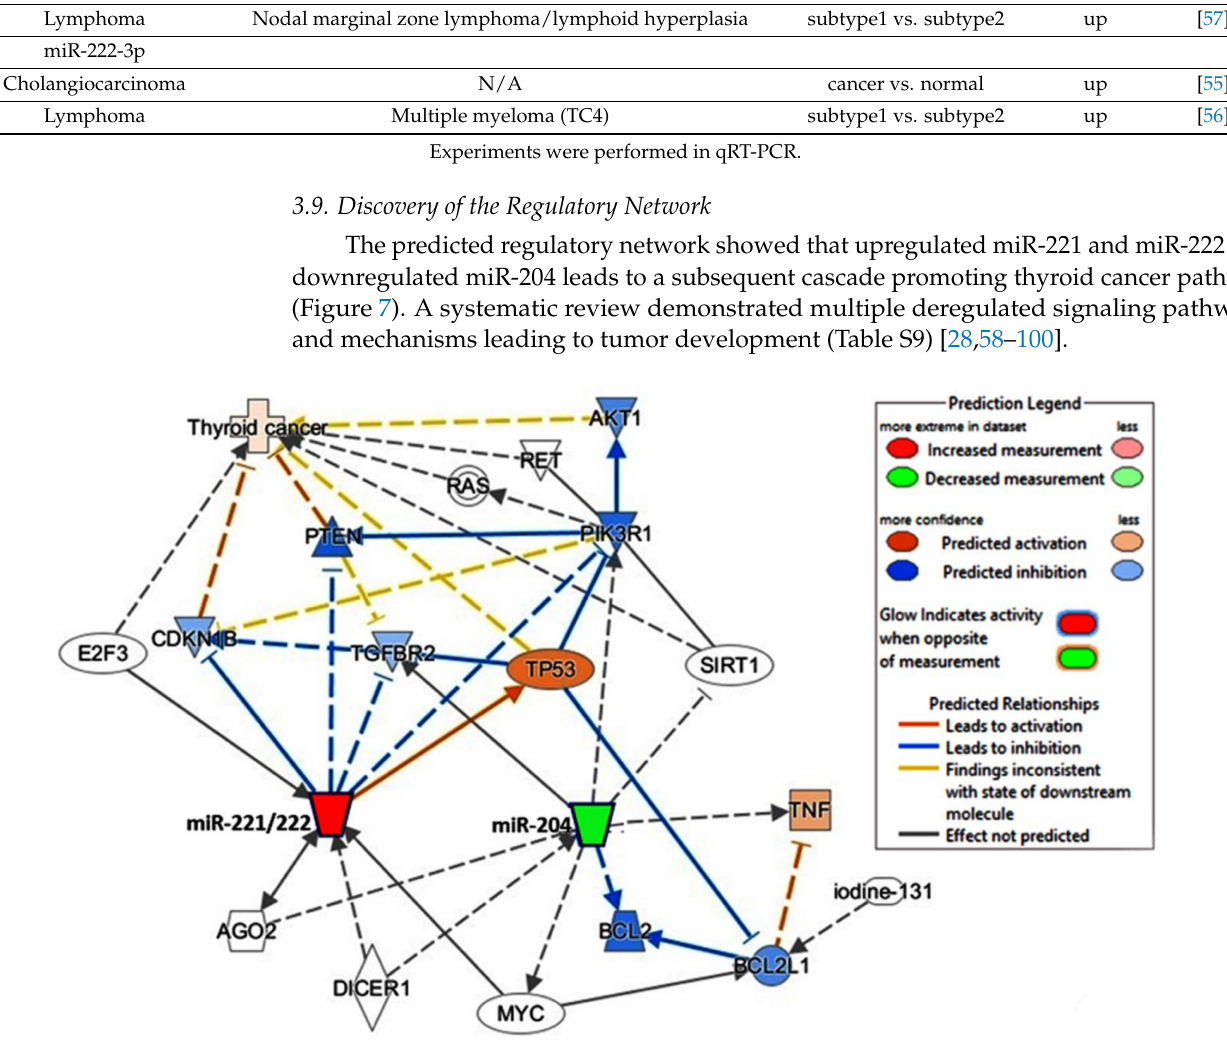
Figure 7. Causal network analysis for the predicted effect of microRNAs deregulation on thyroid cancer disease. Overex- pressed miR-221 and miR-222 (red node) and downregulation of miR-204 (green node) are predicted to activate (orange) and inhibit (blue) genes, which lead to activation of thyroid cancer KEGG pathway. Data source: Knowledge base Ingenuity Pathway Analysis (IPA, Qiagen Inc., https://www.qiagenbioinformatics.com/products/ingenuity-pathway-analysis) (accessed on 21 May